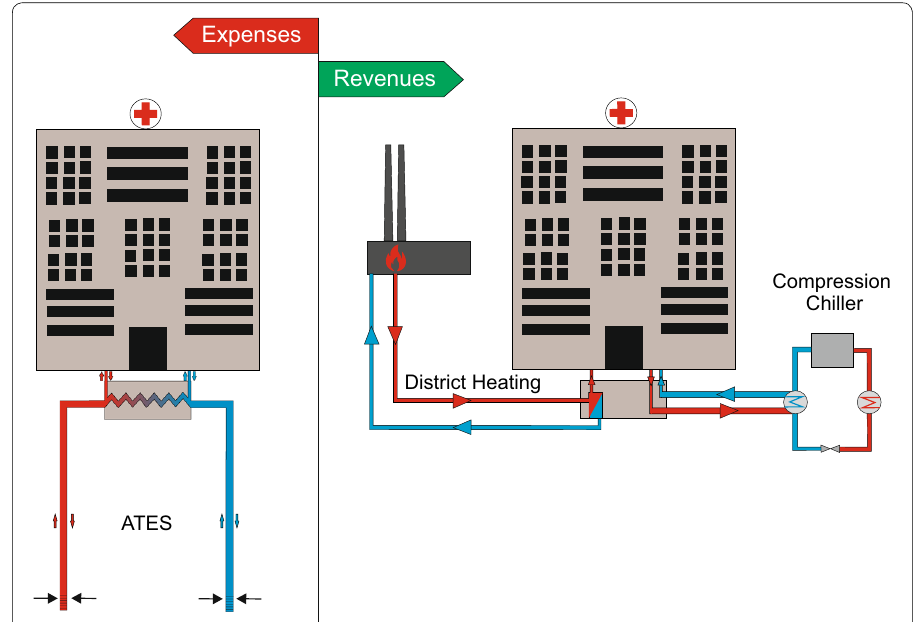
Fig. 4 ATES system and the compared reference systems of the municipal hospital of